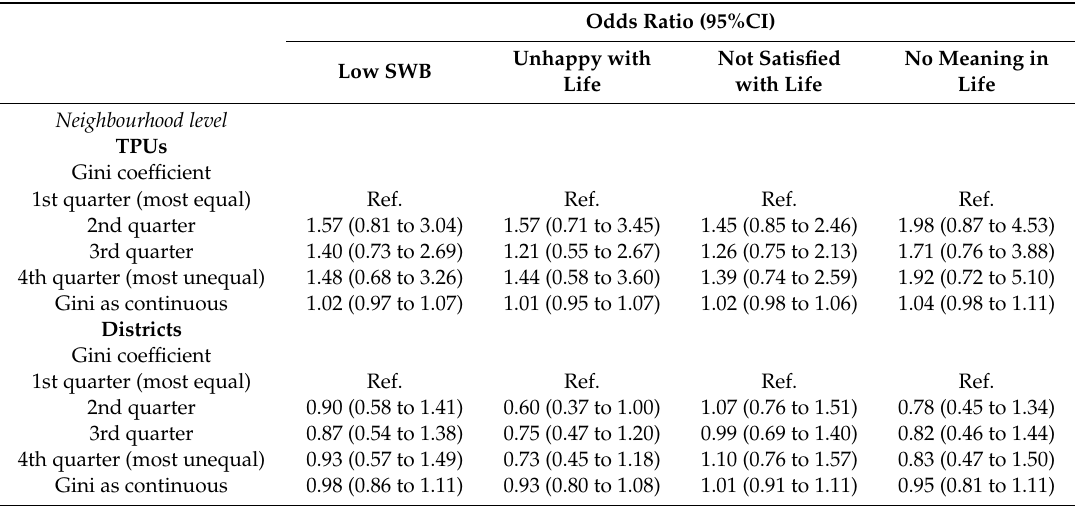
Table 4. Multilevel associations of neighbourhood income inequality and components of and overall subjective